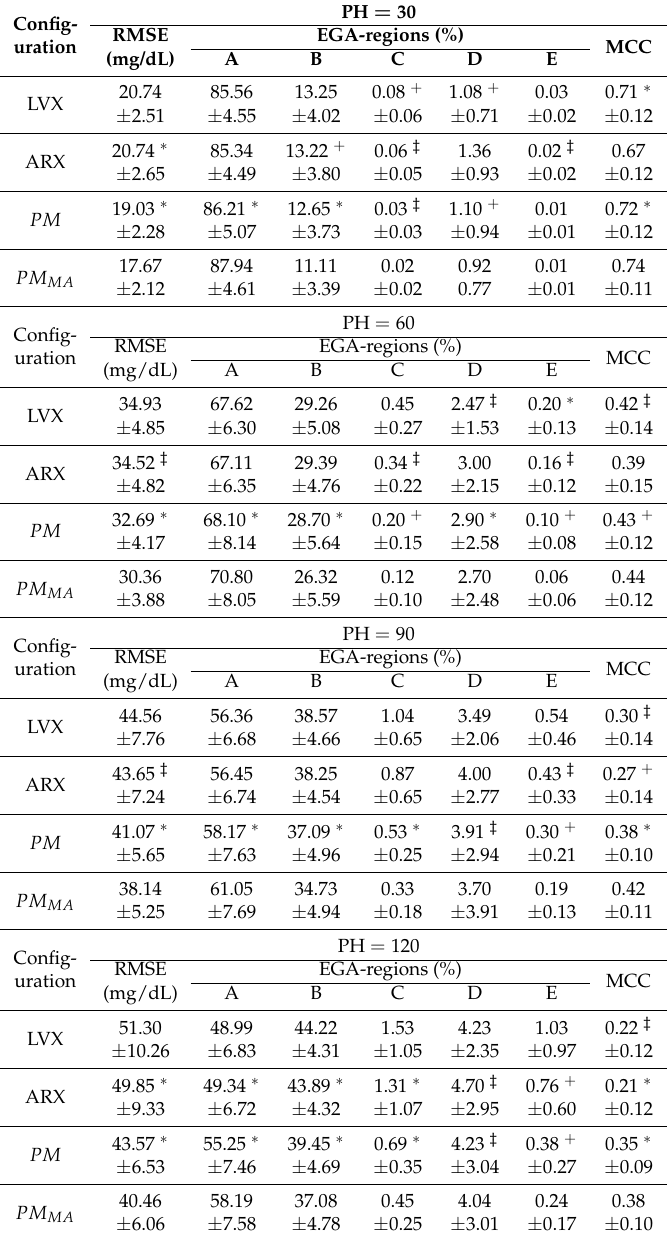
Table 2. Results corresponding to the 10-adult population expressed as Mean ± STD for the studies algorithms and different PH in minutes. Assessment of statistical significance between adjacent rows is indicated with ∗ for p < 0.001, + for p < 0.01, and ‡ for p < 0.05. PH = 30 Config- RMSE EGA-regions uration